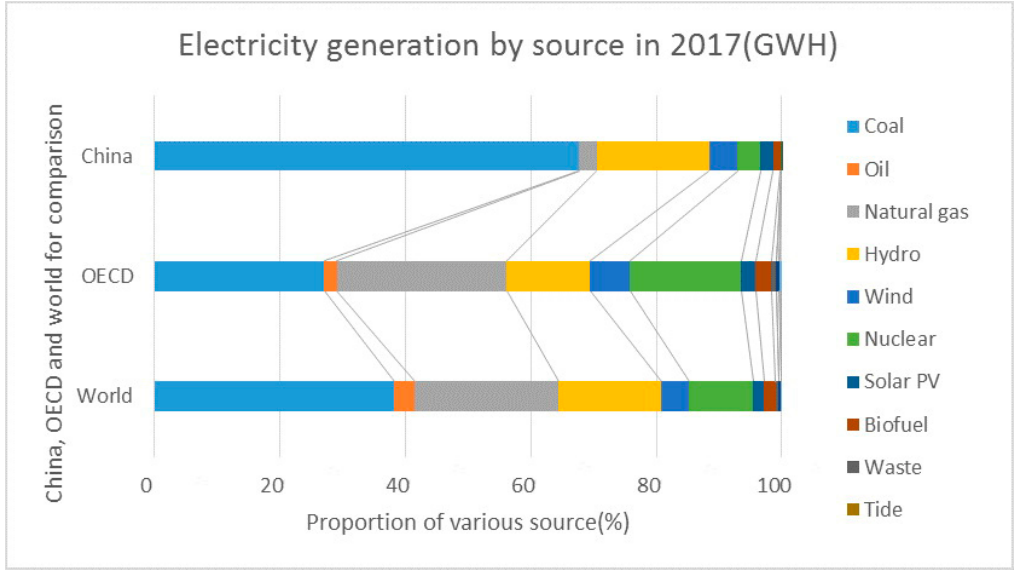
Figure 1. Electricity generation proportion in China by source in 2017 compared with the Organization for Economic Co-operation and Development (OECD) and world. Note: Relevant data are from country profiles of the International Energy Agency (IEA) [32]. In the above figure GWH is shortened for gigawatt hours and Solar PV for solar photovoltaic.